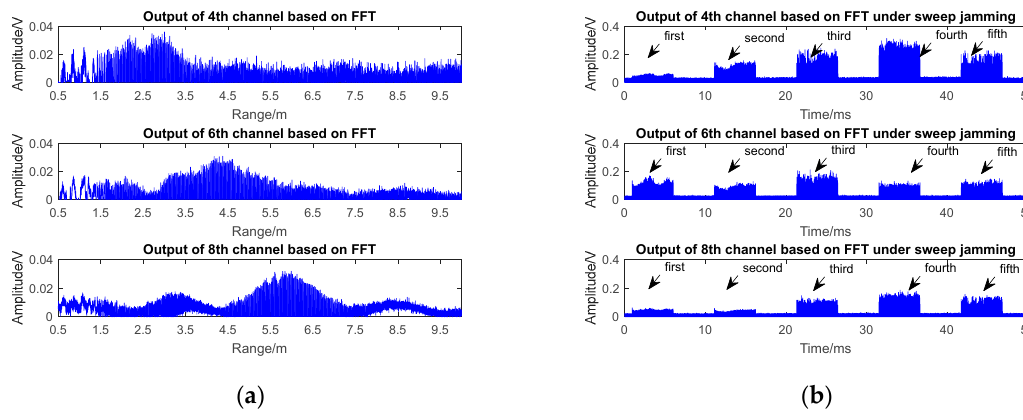
Figure 10. The 4th/6th/8th channel outputs of the prototype. ( a ) Low speed encounter; ( b ) under sweep jamming. (Sweep jamming parameters: f jN − f j 0 = 100 MHz; ∆ f j = 500 KHz; T dw = 4 ms; AM signal: sine; f j M = 1